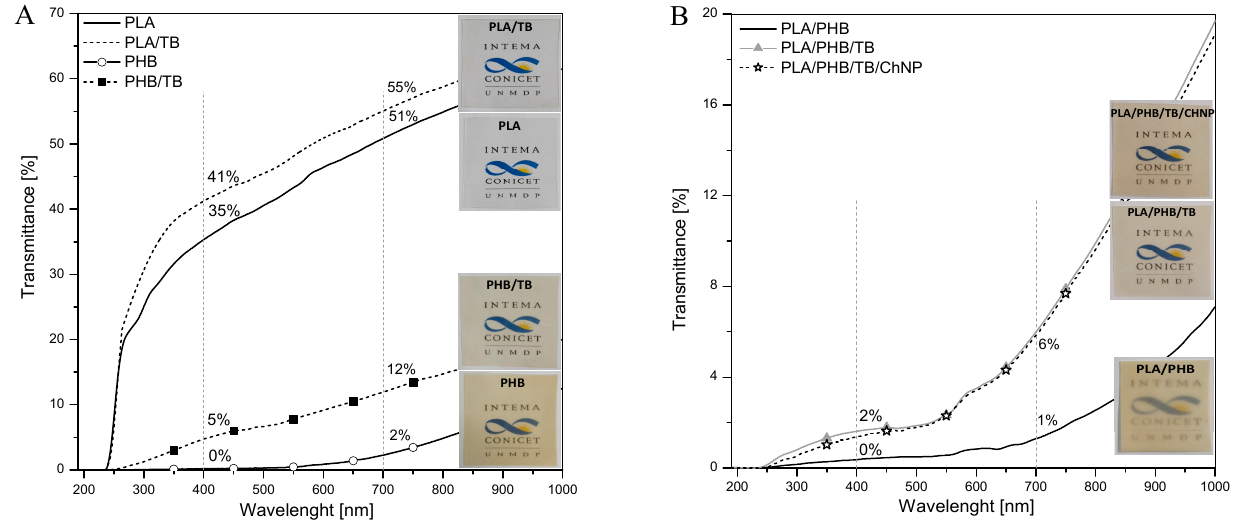
Figure 8. UV–vis spectra and visual appearance of prepared films ( A ) PLA, PLA/TB, PHB, PHB/TB, and ( B ) PLA/PHB, PLA/PHB/TB, PLA/PHB/TB/ChNP. Table 3. Thickness, color parameters ( 𝐿 ∗ : lightness, 𝑎 ∗ : green–red, 𝑏 ∗ : blue–yellow), and opacity for PLA- and PHB-based materials (values in brackets correspond to the standard deviation).